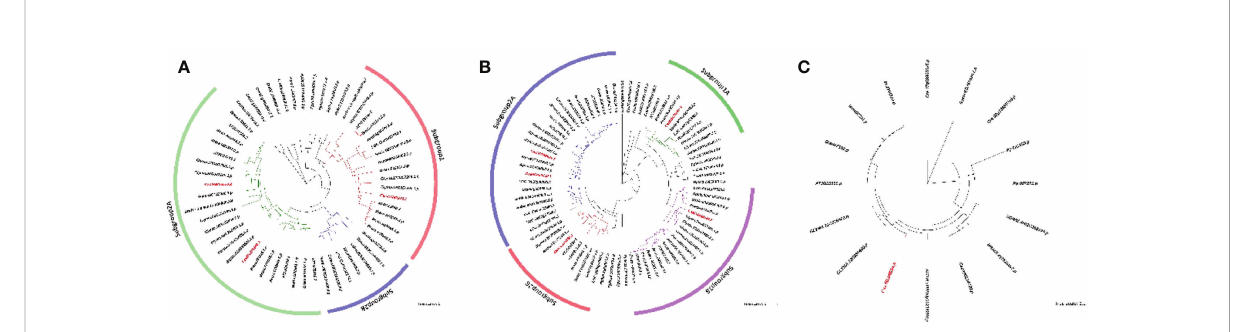
FIGURE 1 Phylogenetic tree of b CA (A) , FBA (B) and SBP (C) in plant species. Unrooted phylogenetic tree was calculated with the Maximum-Likelihood method, using JTT modeling with gamma-distributed rates and 1000 bootstrap replications based on the multiple sequence alignments of b CA and SBP. The fi nal tree was then rooted in the single clade consisted of members from C. reinhardtii . Phylogenetic tree was also constructed with JTT model for FBA proteins and the tree was rooted in the middle of two groups of members from C. reinhardtii . Bootstrap values are indicated at the base of each clade. All target protein in cucumber genome were colored with red in those trees.